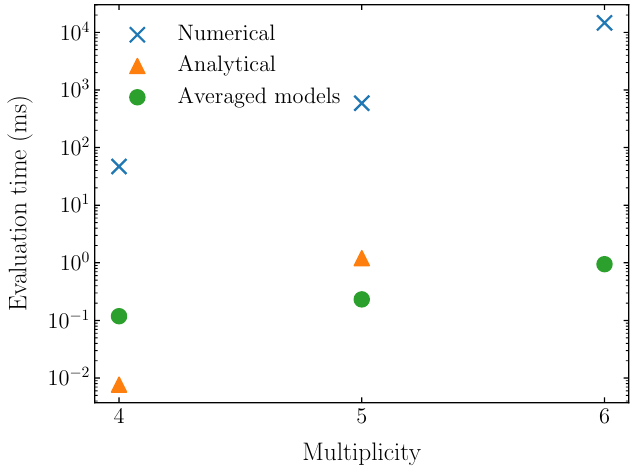
Figure 10. Typical per-point call times for the set of NN ensembles and scaling tests with numerical and analytical techniques against the number of legs. Compared to figure 1, this incurs a twofold cost on the conventional methods and multiplies the single NN ensemble time by 20. Analytical methods are fastest at 2 → 2 and NNs do not offer a dramatic improvement at 2 → 3 either, but their fast call time and weak dependence on the number of variables (which scales with multiplicity) win out at high multiplicity. At 2 → 4 , where no analytical expression is available and extrapolation suggests it would be comparable in call time to numerics, our ML approach is four orders of magnitude faster than the numeric